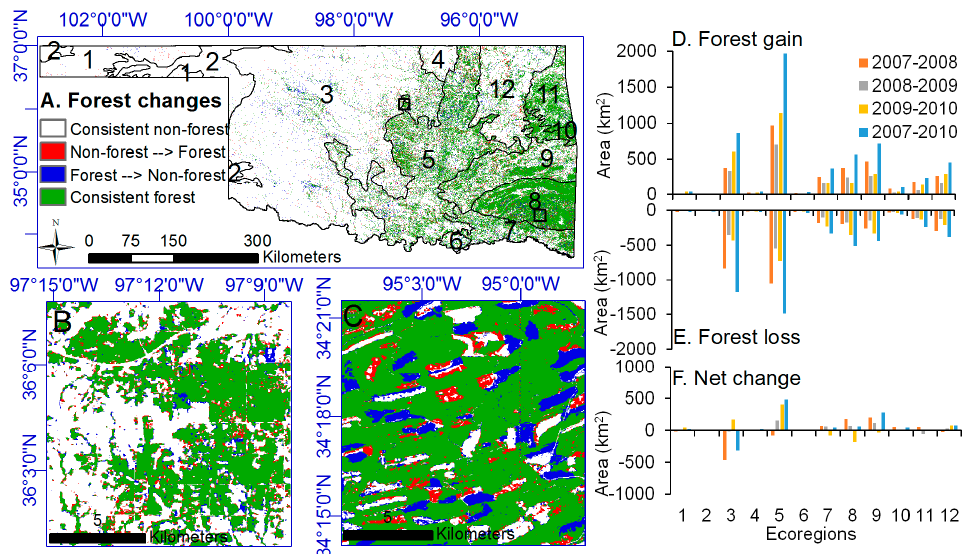
Figure 11. The spatial distribution map of the PALSAR/Landsat forest change in Oklahoma from 2007 to 2010. ( A – C ) are the forest changes in Oklahoma and two zoom-in areas from 2007 to 2010, respectively. ( D – F ) are the statistics of forest gain, forest loss, and net change in ecoregions from 2007 to 2010, respectively.